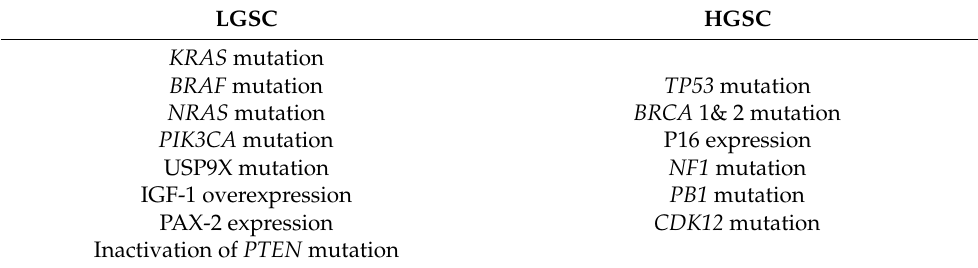
Table 2. Molecular landscape of LGSC vs. HGSC